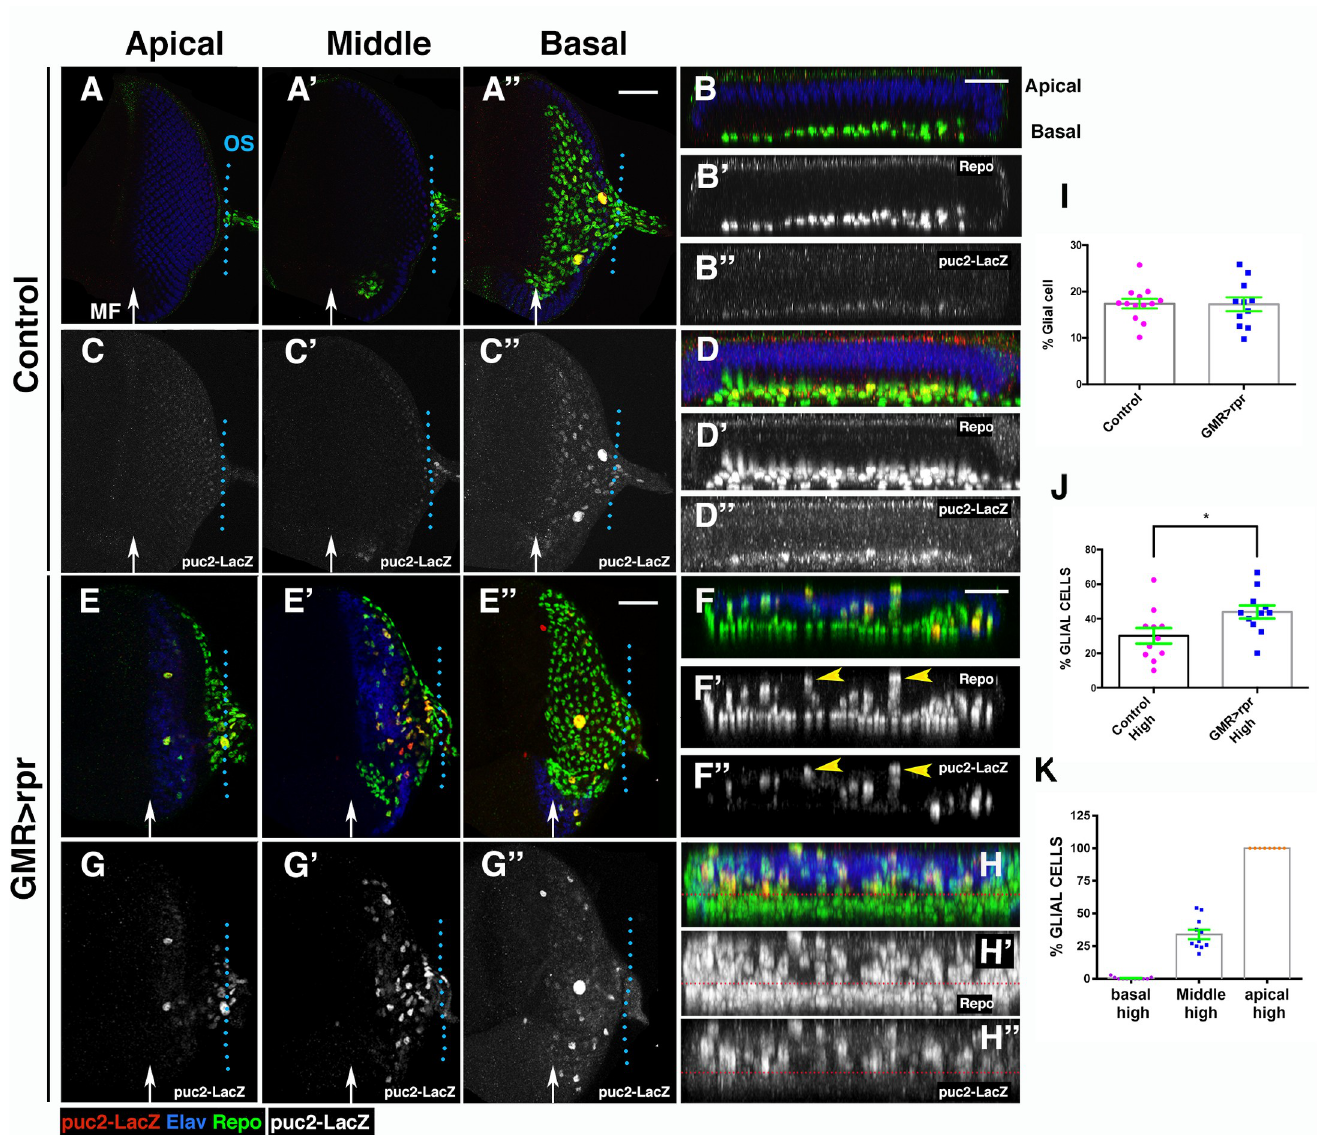
Fig 5. JNK signalling is activated in response to damage. (A–H”) Third instar eye discs stained with anti-Elav (blue), anti-Repo (green in A–A”, B, D, E–E’, F, and H and grey in B’, D’, F’, and H’) and anti-B-galactosidase (red in A–A”, B, D, E–E’, F, and H and grey in C–C”, B”, D”, G–G”, F”, and H”) to reveal the activity of the puc2B-lacZ reporter, in control (GMR-Gal4 tub-Gal80 ts /+; puc2B-lacZ/+ ) (A–D”) and damaged UAS-rpr/+; GMR-Gal4 tub-Gal80 ts /+; puc2B-lacZ/+ discs (E–H”). Apical (A, C, E, and G), middle (A’, C’, E’, and G’), and basal (A”, C”, E”, and G”) layers of control (A–A” and C–C”) and damaged (E–E” and G–G”) eye discs. (B–B” and F–F”) Y–Z projections show 2 cross sections parallel to the furrow in control (B–B”) and damaged (F–F”) discs. (D–D” and H–H”) Projection of transversal sections generated from 5 different control discs (D–D”) and damaged discs (H–H’). Glial cells with higher levels of puc2B-lacZ are preferentially located in apical and middle layers of the discs (yellow arrowheads in F’ and F”). In the plot shown in H–H”, note that most glial cells expressing high levels of puc2B-lacZ are located above the red dotted line. (I) Graph shows the percentage of glial cells expressing puc2-lacZ (n˚ cell expressing puc2B-lacZ /Total n˚ of Glia) in control (control) and damaged UAS-rpr/+; GMR-Gal4 tub-Gal80 ts /+; puc2B-lacZ/+ ( GMR < rpr ) discs. (J) Percentage of glial cells expressing this reporter at high levels (n˚ cells expressing puc2B-lacZ at high levels/total glial cells expressing puc2B-lacZ ) (see Materials and methods). (K) Graph shows the percentage of glial cells expressing puc2B-lacZ at high levels (high) in basal, middle, and apical layers of damaged eye discs. Scale bars, 50 μ m. Statistical analysis is shown in Table E in S1 Text. The numerical data used in this figure are included in S1 Data. GMR, glass multiple reporter; JNK, c-Jun N-terminal kinase; puc , puckered ; rpr , reaper